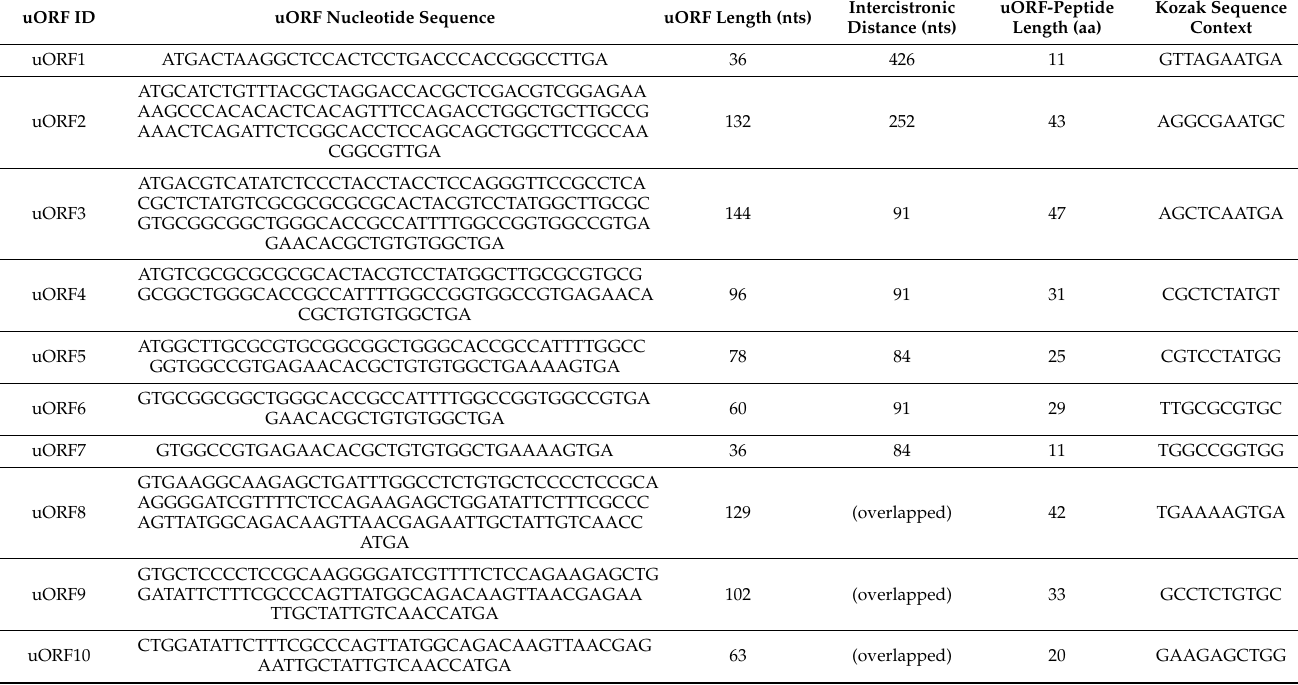
Table 1. Characterization of the AUG and non-AUG uORFs identified in the human ABCE1 5 (cid:48) -leader sequence. uORF ID uORF Nucleotide